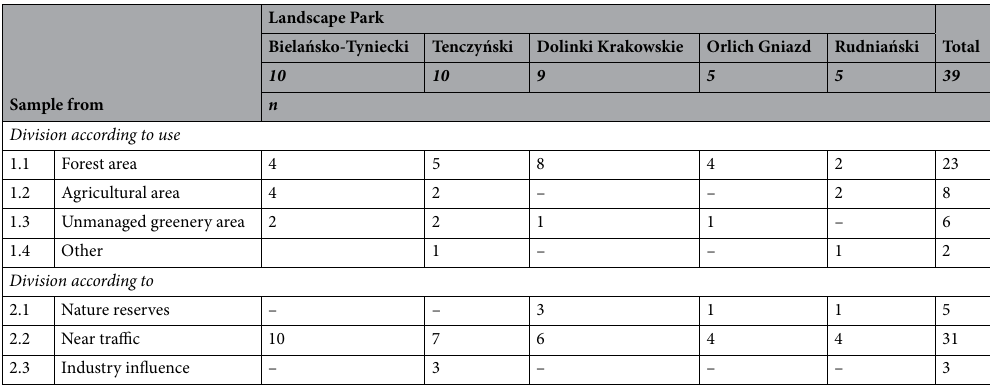
Table 2. The number of soil samples and their collection sites.